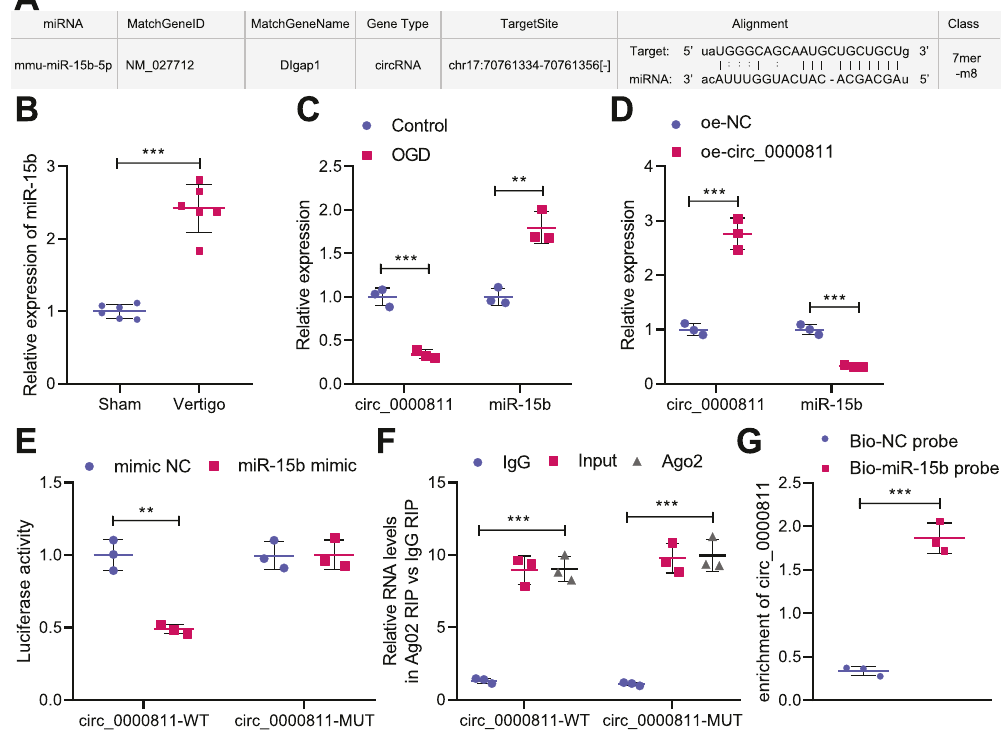
Fig. 3 Circ_0000811 acted as a sponge for miR-15b. A The binding site between circ_0000811 and miR-15b sequence predicted by the Starbase database; B qRT-PCR to determine the expression of miR-15b in the MVN of mice with CI-induced vertigo and sham-operated mice; C qRT-PCR to determine the expression of circ_0000811 and miR-15b in the OGD-exposed cell model; D qRT-PCR to determine the expression of circ_0000811 and miR-15b in OGD-exposed cells in the presence of oe-circ_0000811; E dual luciferase reporter assay to validate the binding af fi nity between circ_0000811 and miR-15b; F , G RIP assay ( F ) and RNA pull-down assay ( G ) to verify that circ_0000811 binds to miR-15b. ** p < 0.05, *** p < 0.001. Independent sample t test was applied for the comparison between two groups, and one-way ANOVA with Tukey ’ s post hoc test was applied for the comparison among multiple groups. Cell experiments were repeated three times. qRT-PCR quantitative reverse- transcription polymerase chain reaction, MVN medial vestibular nucleus, OGD oxygen glucose deprivation, RIP RNA